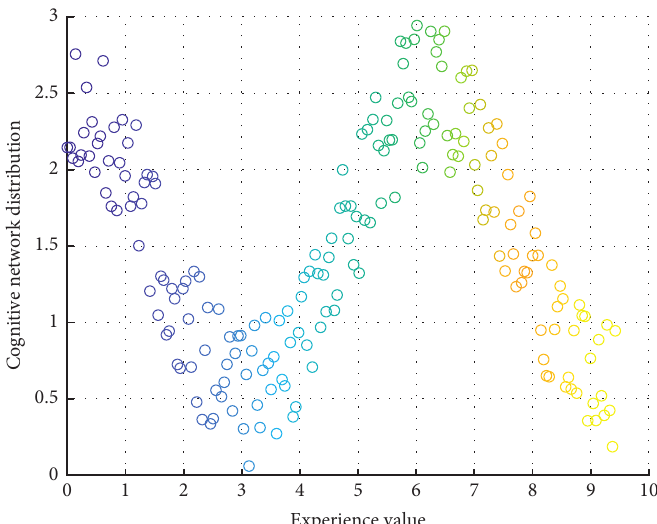
Figure 4: Cognitive network diagram of learners in experienced group ( E ) and inexperienced group ( I ).